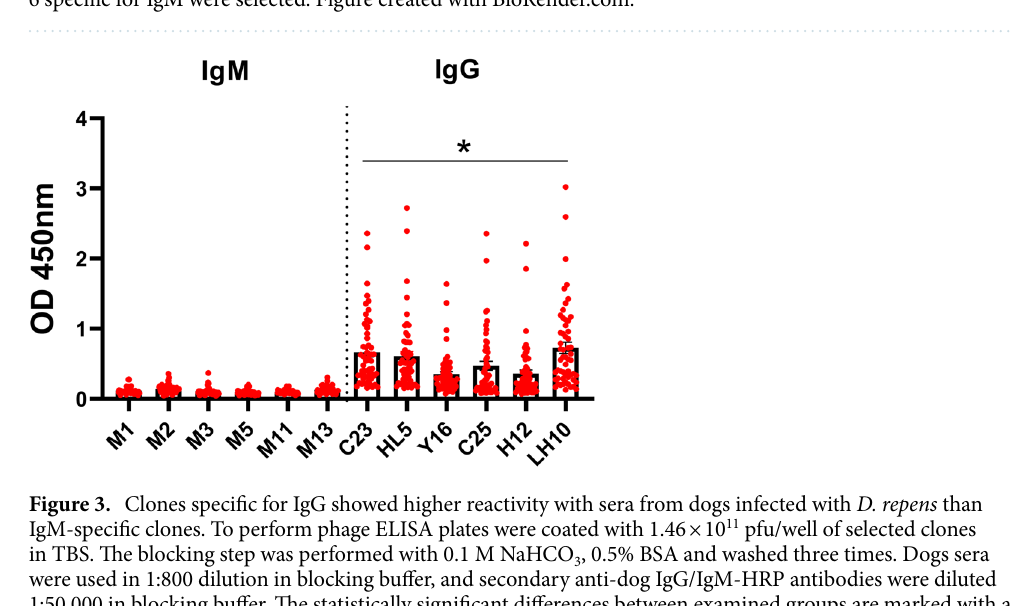
Figure 2. Screening of phage display peptide library enabled selection of 12 clones specific for both Dirofilaria repens IgG and IgM antibodies. Before actual biopanning, screening steps with sera from D. repens non-infected dogs, dogs infected with T. leonina and U. stenocephala and mice infected with T. canis were performed. After 3–4 rounds of actual biopanning with D. repens positive dogs sera 6 clones specific for IgG and 6 specific for IgM were selected. Figure created with BioRender.com.